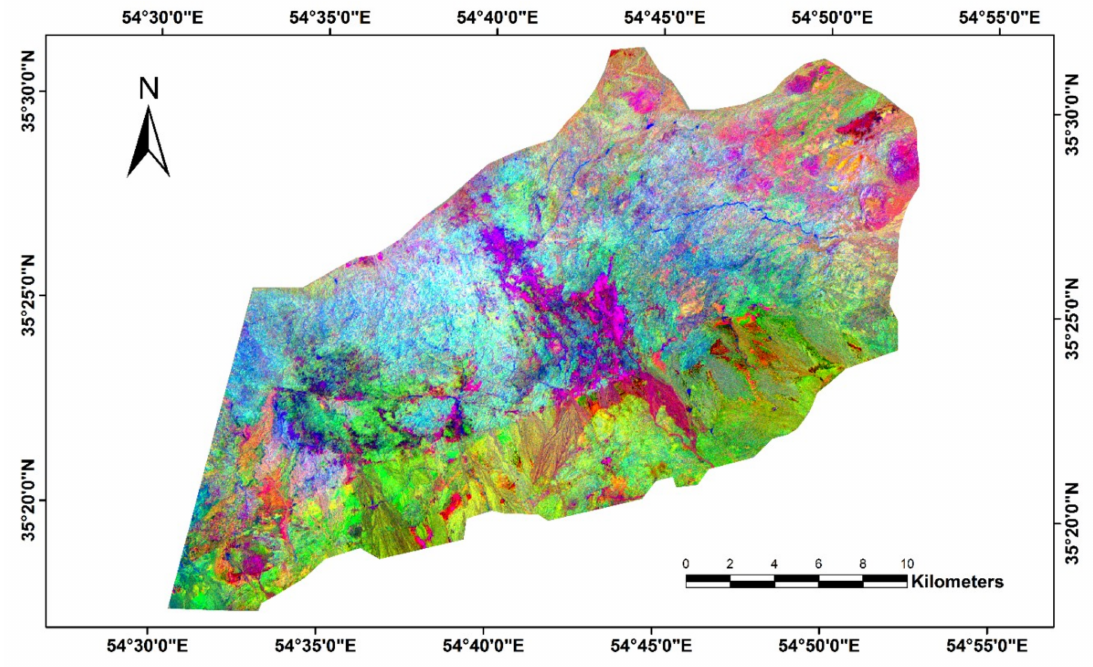
Figure 6. RGB false color composite of the BT1 (R), BT2 (G), and BT3 (B) derived from the BRMT algorithm for the study